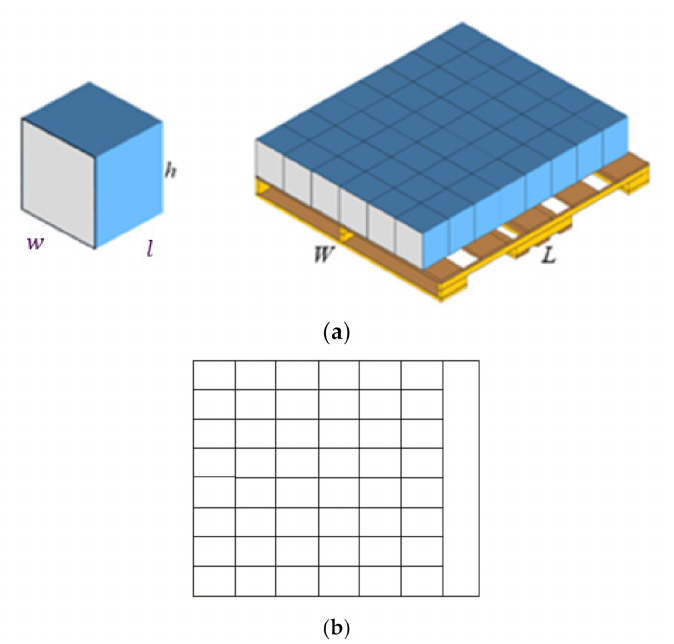
Figure 2. One-block heuristic. ( a ) Arrangement of boxes per horizontal layer using the one-block heuristic. ( b ) Top view for the horizontal layer using the one-block heuristic. In the three-block and five-block heuristics, the layout of the layer is divided into three and five blocks, respectively (Figure 3). The boxes in each block should be arranged uniformly in either an H-box or V-box orientation